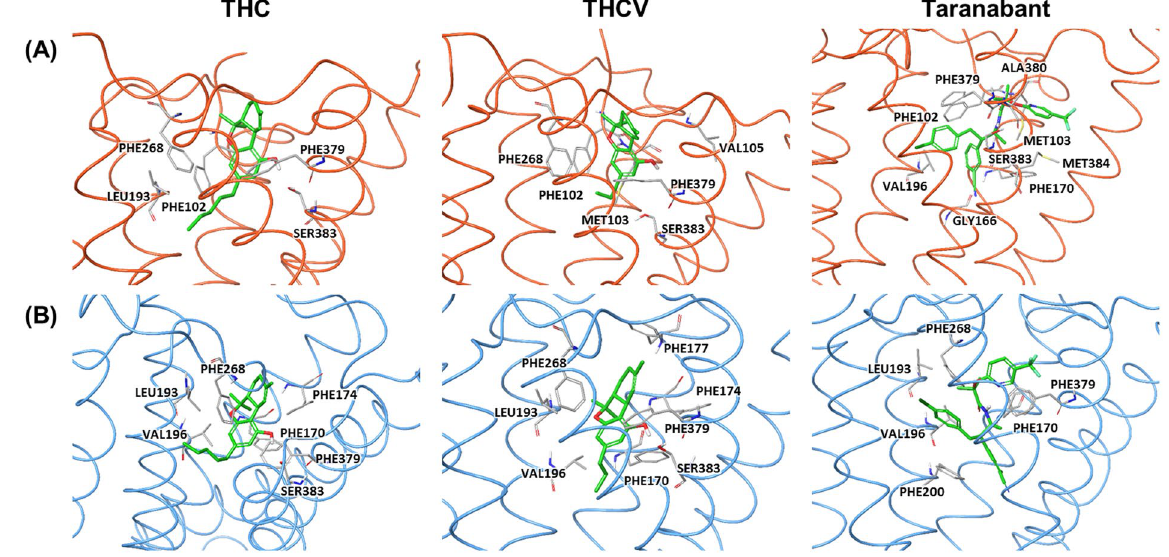
Figure 8. Binding poses of CB1 ligands after 1 μ s MD simulations. Three ligands were bound to the ( A ) inactive and ( B ) active conformations of CB1 receptor. The residues with high energy contribution are